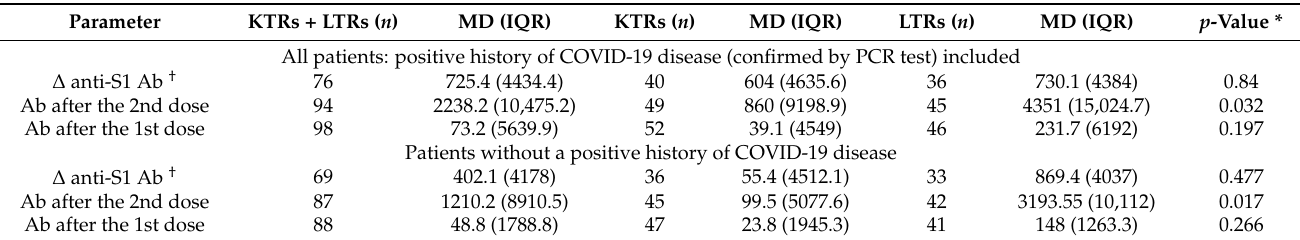
Table 2. Comparison of SARS-CoV-2 spike protein Ab concentration (AU/mL) after BNT162b2 vaccination in KTRs and LTRs.